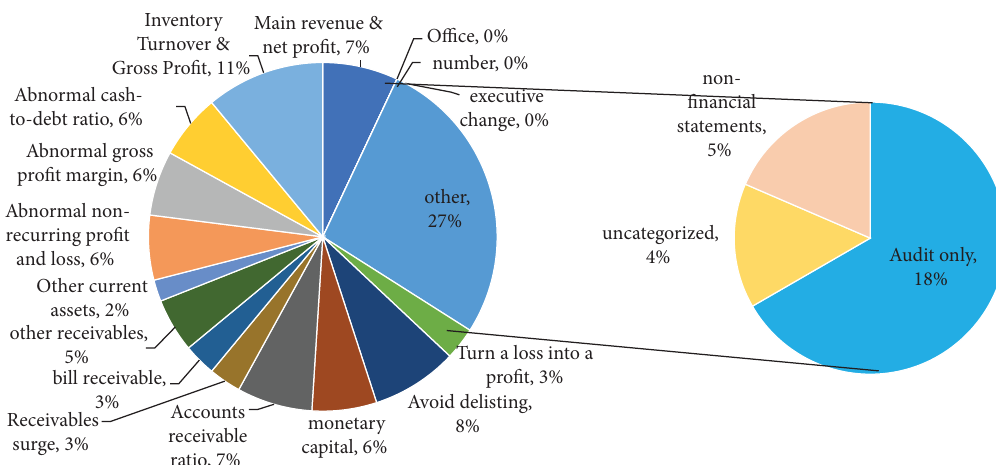
Figure 6: Te importance of variables in the overall fnancial risk assessment of enterprises.